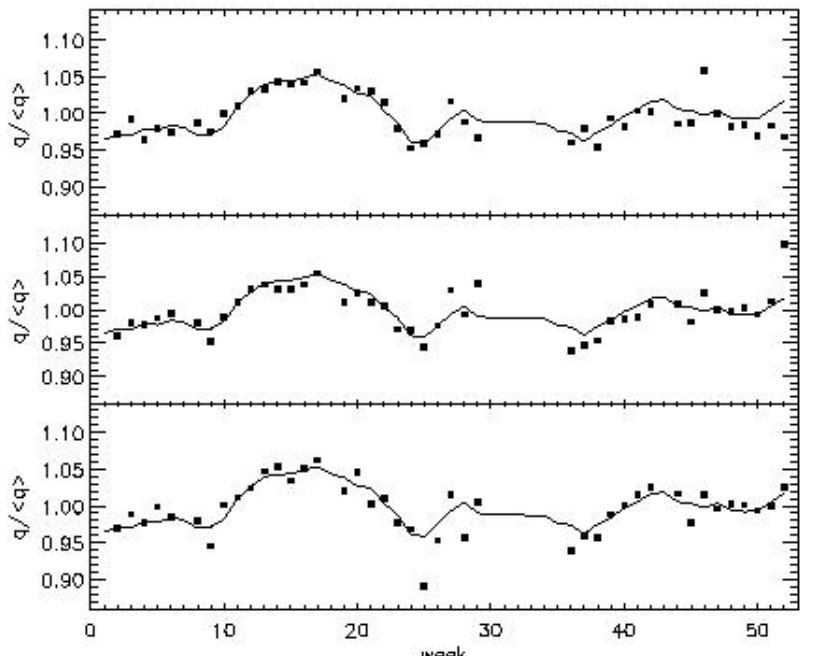
Figure 4. The seasonal index, defined as the ratio between the average weekly volume and the annual average, for the morning rush hour (top), the off-peak (centre) and the evening rush-hour (bottom). The solid line represents the smoothed seasonal index for the average daily traffic volumes. The figure shows network he seasonal variation at a link level. We looked at the daily residuals, which are